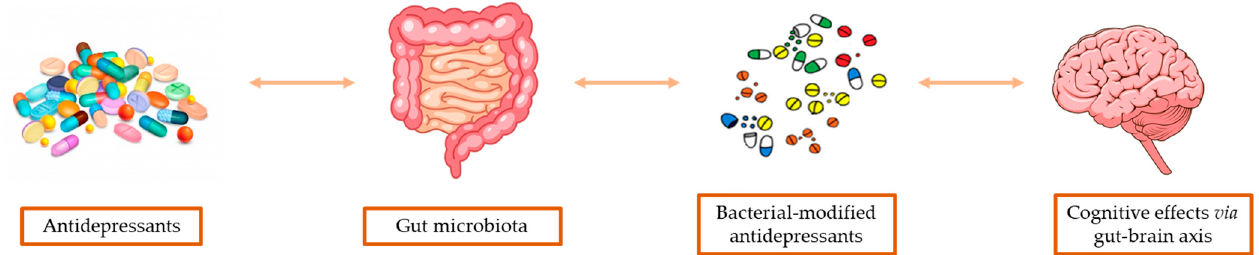
Figure 1. Schematic representation of antidepressant pharmacomicrobiomics.